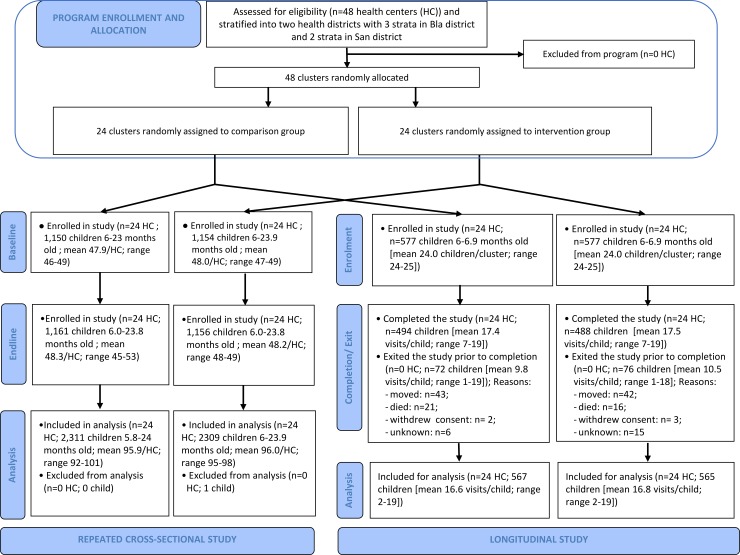
Trial profile for repeated cross-sectional study and longitudinal study.HC, health center.